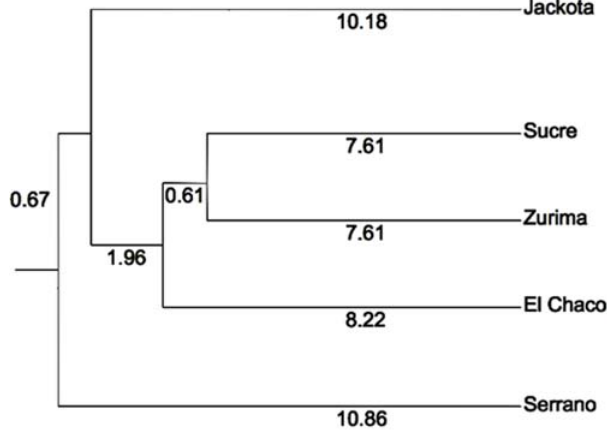
Figure 2. Dendogram of 5 populations of T. infestans from Chuquisaca, Bolivia. Dendogram based on Nei’s (1978) standard genetic distance using the UPGMA method modified from the Neighbor procedure of Phylip version 3.5. Numbers are distances between nodes.